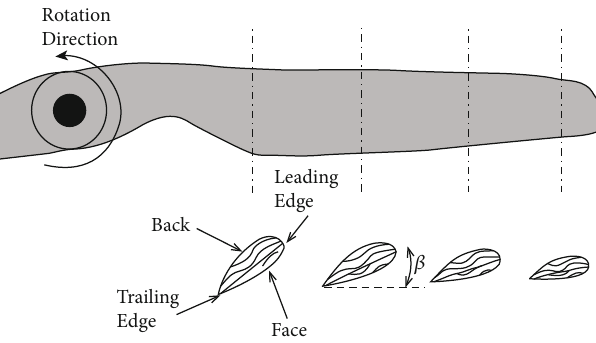
Figure 5: Cross-sections of the propeller blade [21,